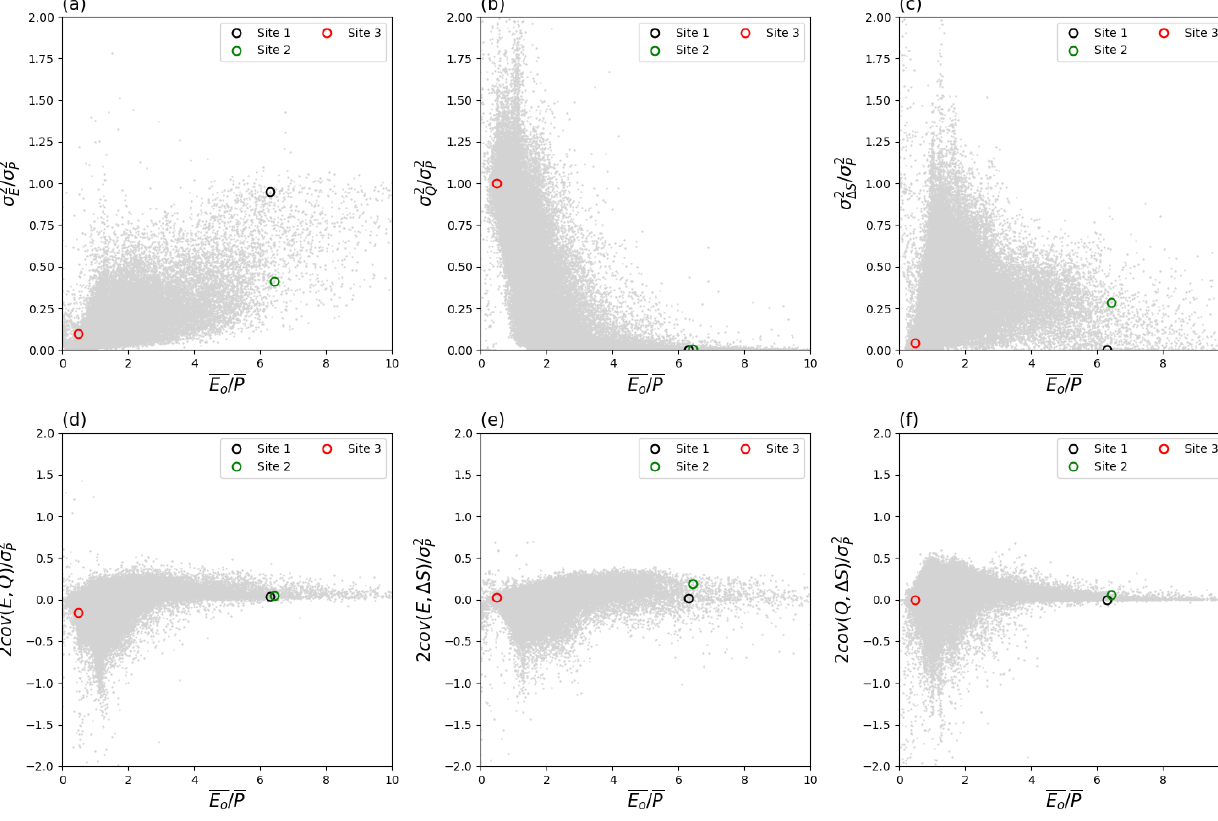
Figure 11. Location of three case study sites in the water cycle variability space. The grey background dots are from Fig.